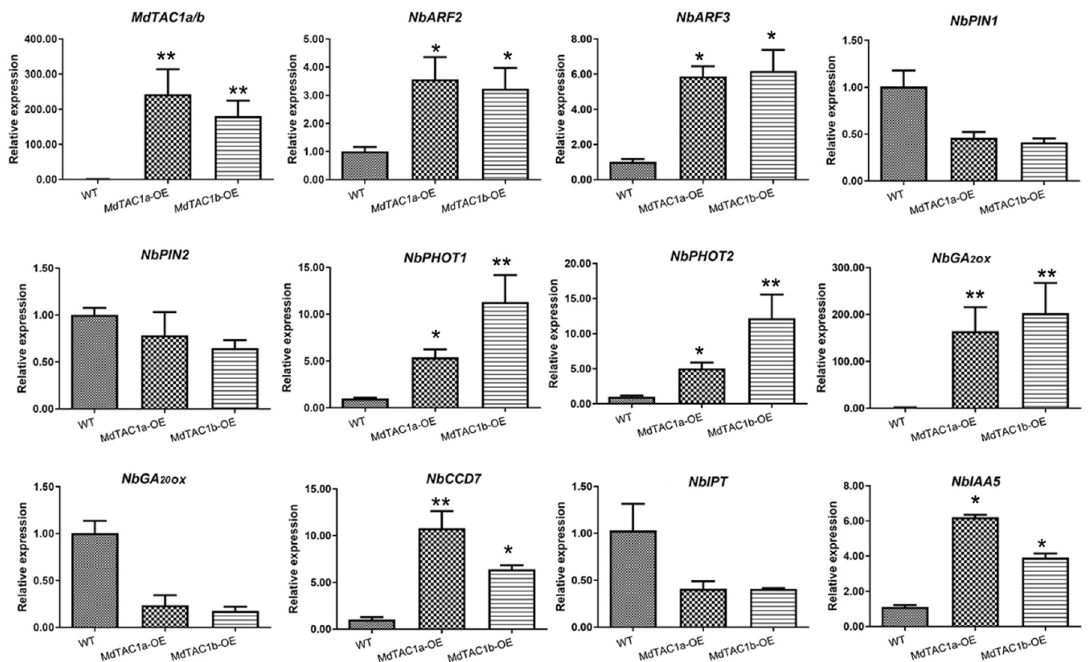
Figure 3. Expression profiles of 12 key genes involved in synthesis and signaling pathways in the WT and transgenic plants eight weeks after transgenic. Error bars represented the standard error of the mean for three biological replicates. The results showed the gene relative expressions in the MdTAC1a and MdTAC1b transgenic lines were significantly more than that of the wild type in tobacco. The significance of difference was analyzed with two-tailed t -test (* 0.01 < p < 0.05, ** p < 0.01). Data were represented as average values with SD.